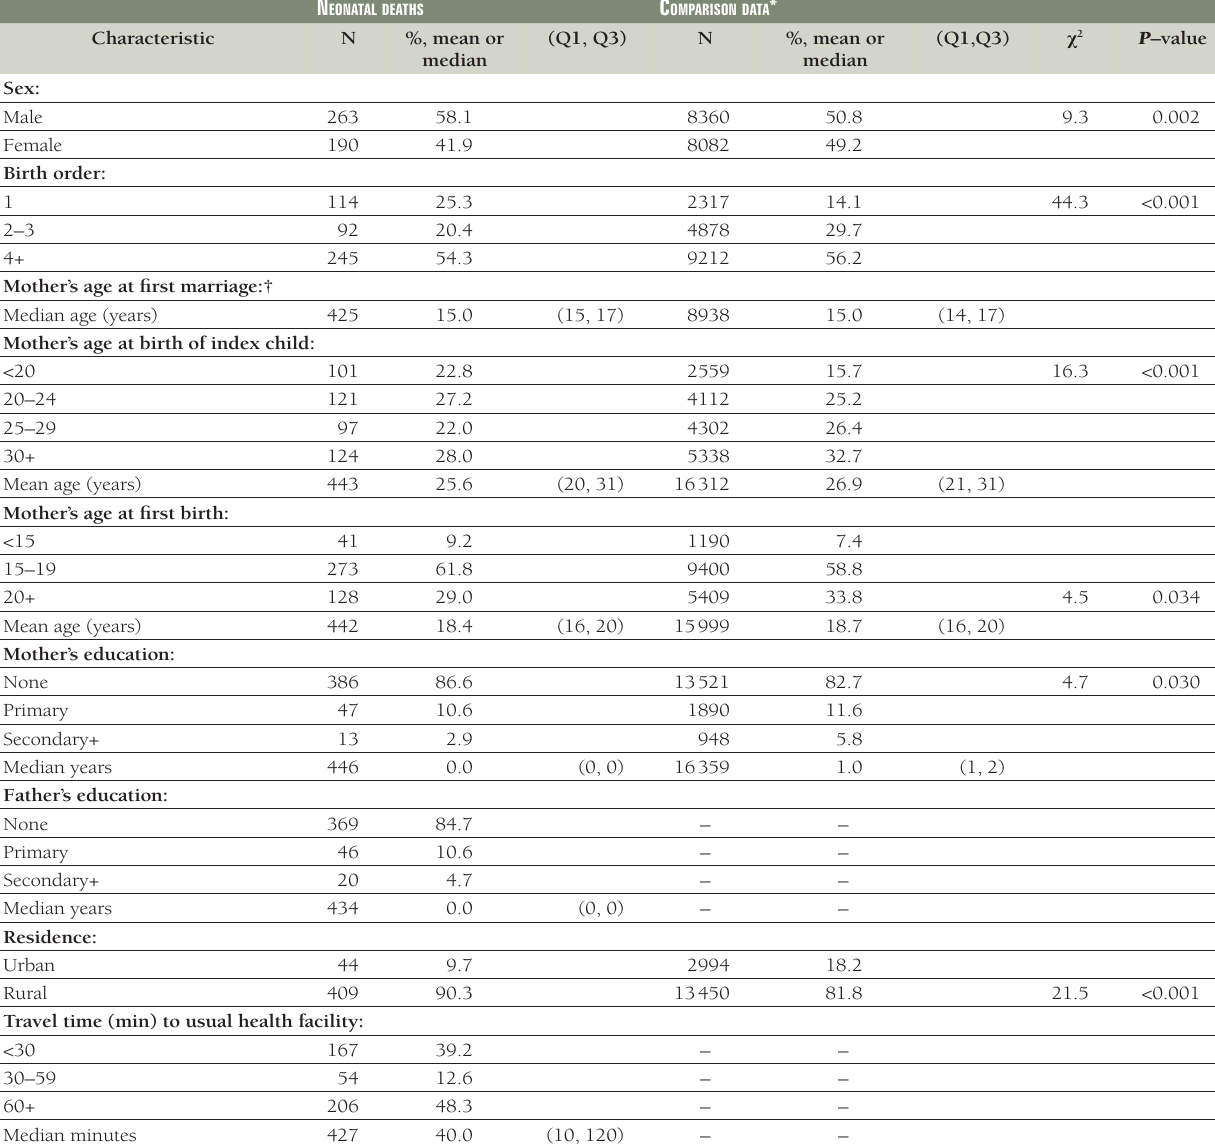
Table 1. Comparison of demographic characteristics of 453 neonatal deaths with those of the general population, Niger, 2007–2010 N eoNatal deaths C omparisoN data